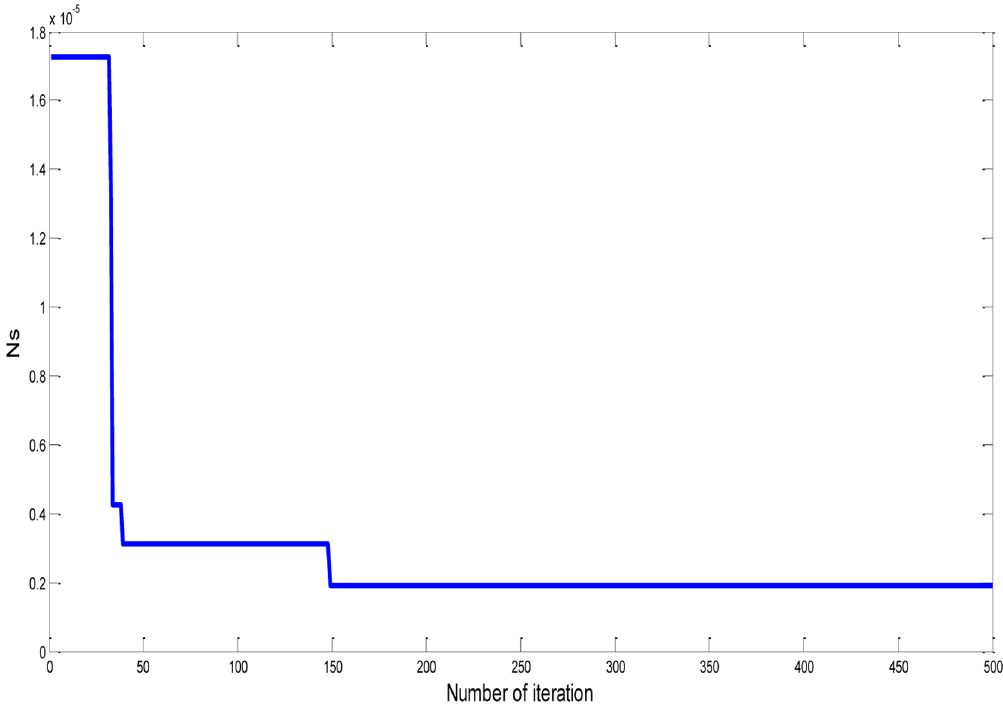
Figure 6. Dimensionless total entropy generation rate ( Ns ) of RPF with e ~ 0 : 5 and P=8.467. doi:10.1371/journal.pone.0066080.g006 PLOS ONE |